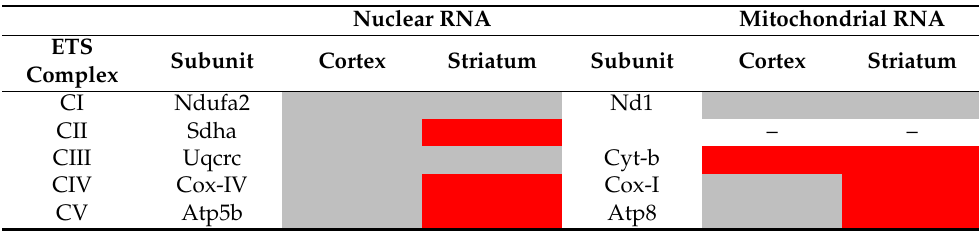
Table 1. Summary of altered RNA levels of components of mitochondrial electron transport system and ATP-synthase in R6/2 brains. Red shading indicates reduced RNA levels in R6/2 cortex or striatum as compared to wild-type; grey shading indicates no differences. Brain Sci. 2021 , 11 , x FOR PEER REVIEW 4 of 13